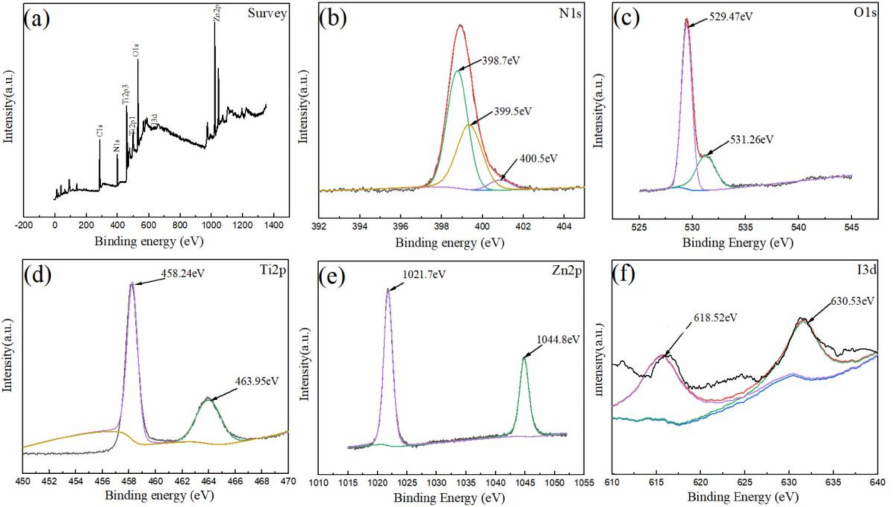
Figure 4. ZIF-8@TiO 2 (5%KI) XPS analysis diagram. ( a ) XPS diagram of ZIF-8@TiO 2 (5%KI), ( b ) XPS diagram of N element, ( c ) XPS diagram of O element, ( d ) XPS diagram of Ti element, ( e ) XPS diagram of Zn element, ( f ) XPS diagram of I element.